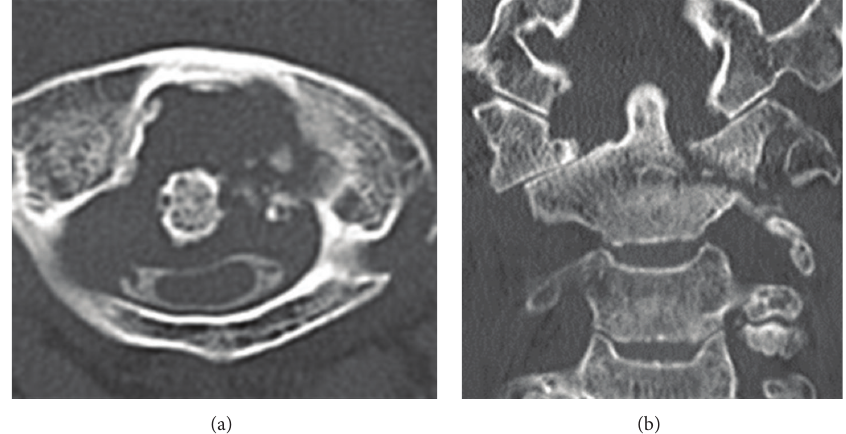
Figure 3: Computed tomography images after myelography showing destruction of the atlantoaxial joint on the left side and compression of cervical spinal cord. (a) Axial view. (b) Coronal